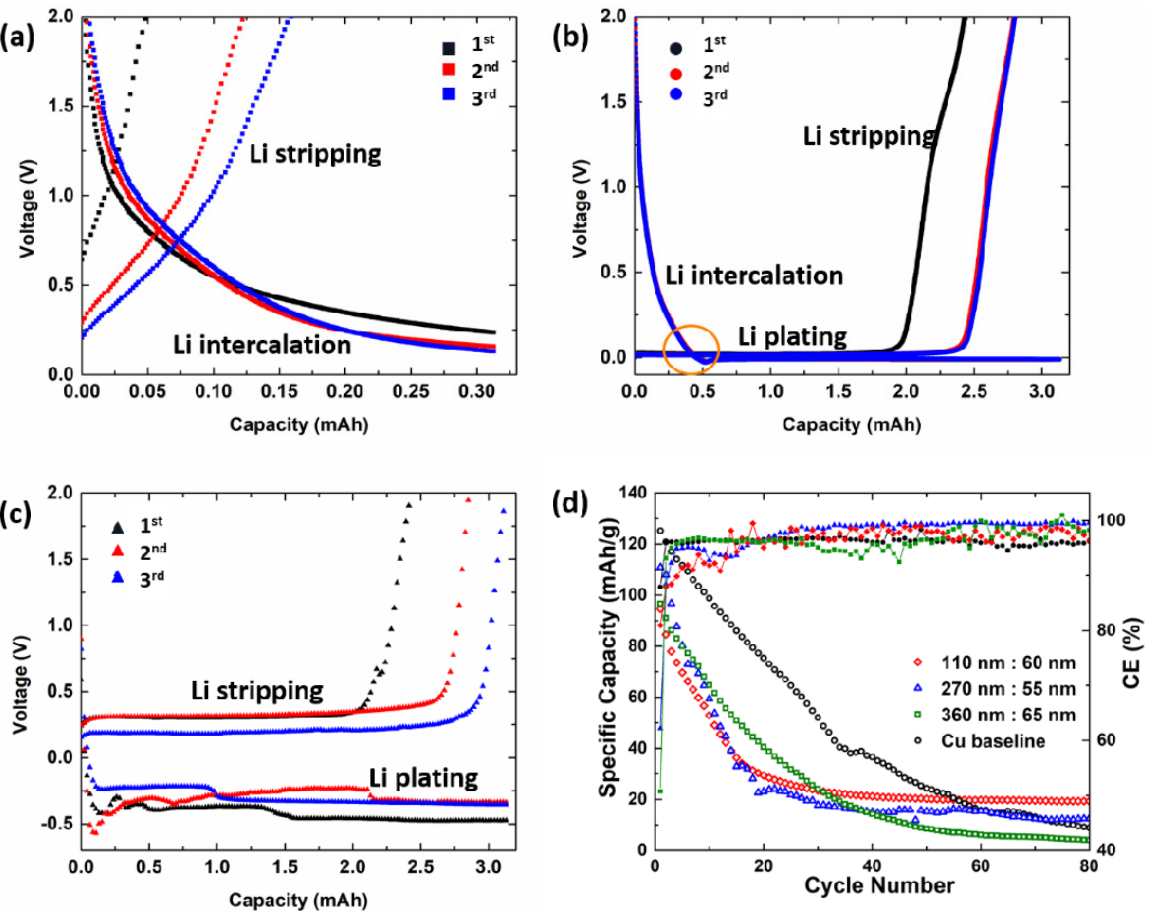
Figure 3. Voltage–capacity plots of the first, second, and third cycle of Li|PHCCSs@Cu cells recorded under different capacity limitations: ( a ) 0.372 mAh (geometric hollow core capacity, charging/discharging C-rates of 0.2 C/0.5 C (0.626 mA/1.565 mA)), ( b ) 3.13 mAh (full cathode capacity, ≈ 9 × of geometric hollow core capacity, charging/discharging C-rates of 0.2 C/0.5 C (0.626 mA/1.565 mA)) and ( c ) 3.13 mAh (charging/discharging C-rates of 5 C/5 C (15.65 mA/15.65 mA)); ( d ) specific capacity and CE of Cu|LiCoO 2 and various sizes of PHCCSs@Cu|LiCoO 2 full cells (charging/discharging C-rates of 0.2 C/0.5 C (0.626 mA/1.565 mA)). Figure 4 shows the in situ images of the deposition of the lithium on the PHCCSs@Cu, along with the voltage–capacity curves. The current densities were set to 0.5, 1, and 2 C-rates in the coin cell (or 1.565, 3.13, and 6.26 mA/cm 2 , respectively). The voltage of the PHCCSs@Cu|Li cells dropped below 0 V after applying the current for 60 min, 24 min, and 10 min (blue, red, and green lines), respectively, under these three C-rates. By contrast, the voltage of the Cu|Li cell dropped below 0 V in less than 1 min when applying the current (black line). The gradual voltage changes in the PHCCSs@Cu|Li cells implies the lithium’s intercalation into the carbon coating, which is consistent with the coin-cell results. On the other hand, high current densities led to reduced capacities of the lithium intercalation, which was also consistent with the coin-cell results. Furthermore, the images recorded under 1 C during the lithium deposition process show the appearance of lithium at the copper surface and the carbon-coated surface at the same time, indicating that lithium prefers to deposit at any location that has a low nucleation overpotential and a short diffusion pathway, further demonstrating the difficulty of the lithium passing through the carbon walls and depositing inside the carbon spheres. A complete video of the lithium intercalation/deposition process was recorded and is provided in Video S1 (Supplementary